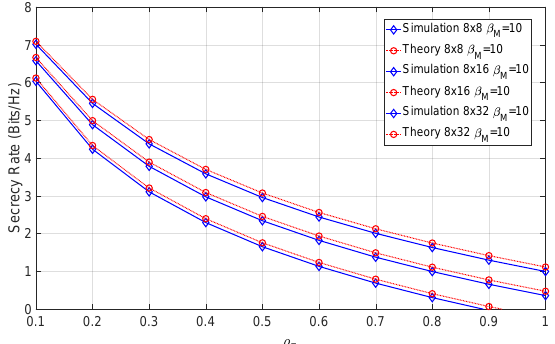
Figure 10. Secrecy rate of the system for various numbers of eavesdroppers and β M = 10, at 12 dB